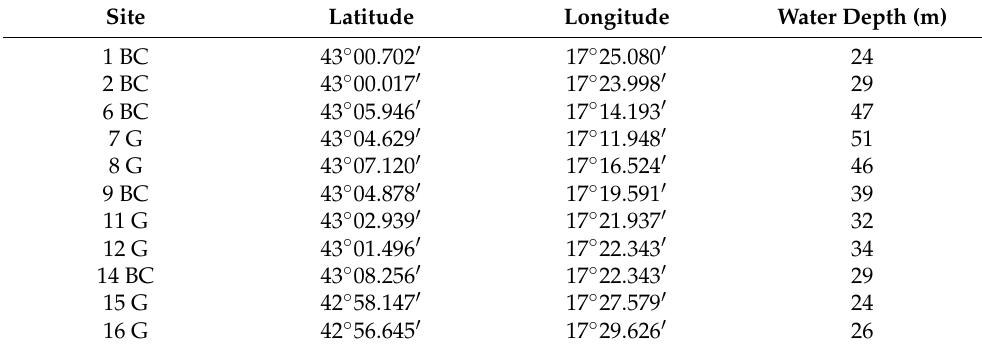
Table 1. List of the 11 sites considered in this study with geographical coordinates and water depth. Site Latitude Longitude Water Depth (m) 1